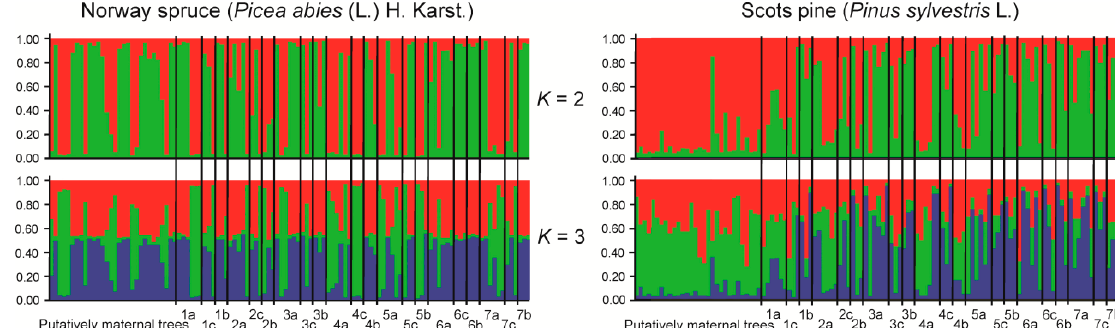
Figure 5. Graphical output of STRUCTURE results for K = 2 and K = 3 in populations of Norway spruce ( Picea abies (L.) H. Karst) and Scots pine ( Pinus sylvestris L.). Putatively maternal trees—mature trees of the respective species from adjacent surrounding stands (30 trees of each species); while nos. 1a to 7a, 1b to 7b and 1c to 7c indicate groups of three to six sampled self-regenerating juveniles of respective species in each of the respectively numbered sample plots (see Figure 2).